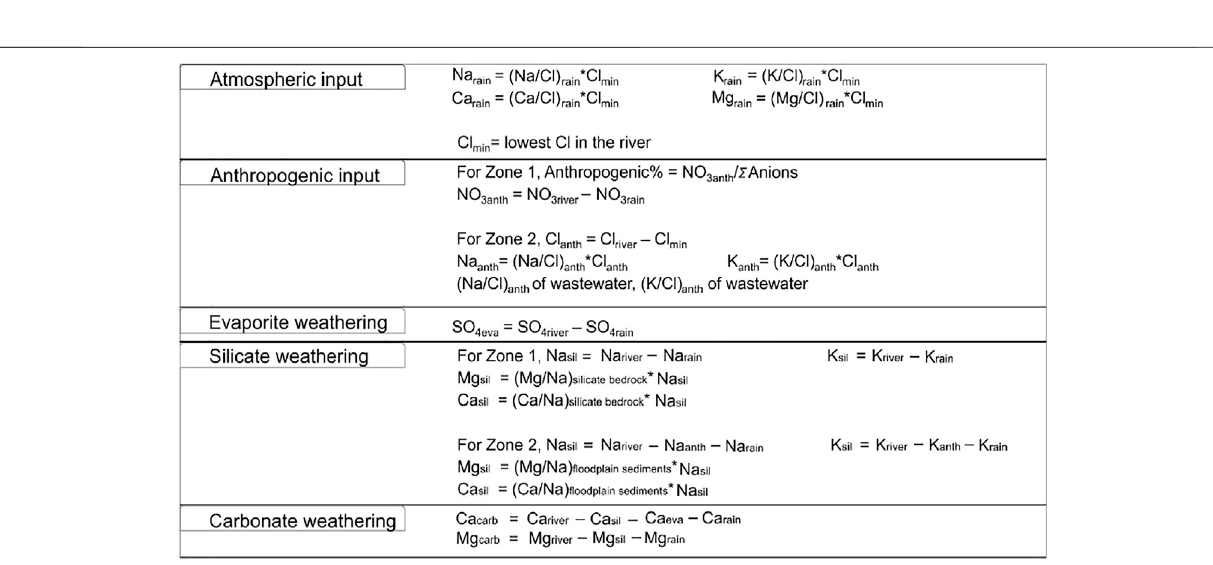
FIGURE 3 | Framework of the forward model depicting contribution from fi ve